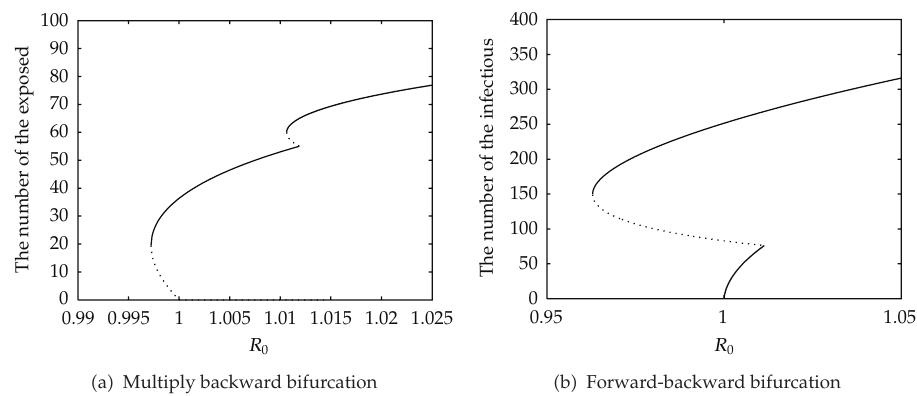
Figure 7: (cid:2) a (cid:3) Double backward bifurcations for model (cid:2) 3.10 (cid:3) . The upper one occurs when R 0 > 1. (cid:2) b (cid:3) Forward-backward bifurcation for model (cid:2) 3.10 (cid:3) . The upper one occurs when R 0 < 1. Dotted lines represent unstable equilibria, and solid lines represent stable